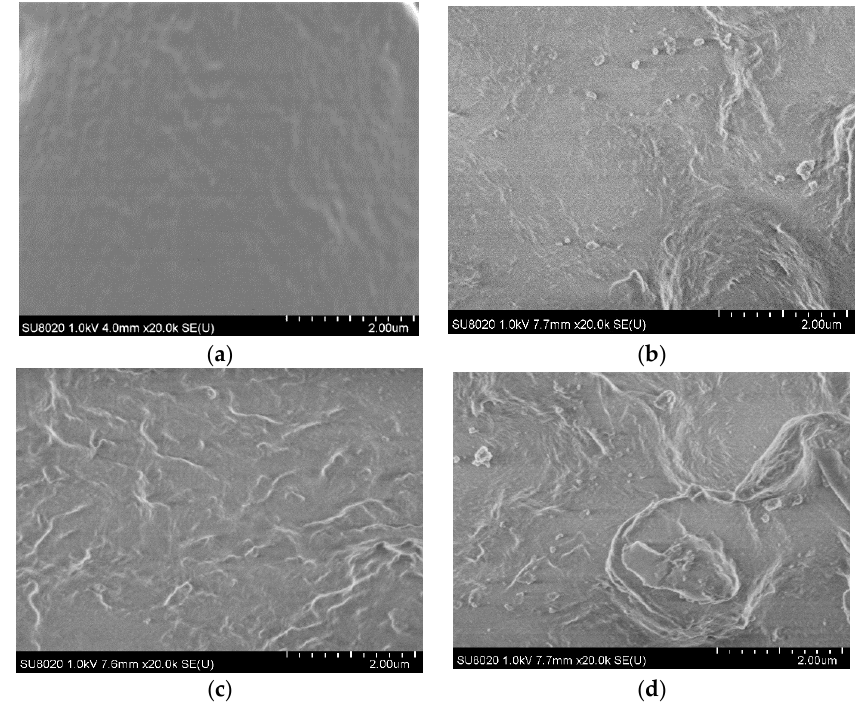
Figure 3. SEM patterns of the samples: ( a ) LDPE, ( b ) N3, ( c ) M3, ( d ) N3M2.